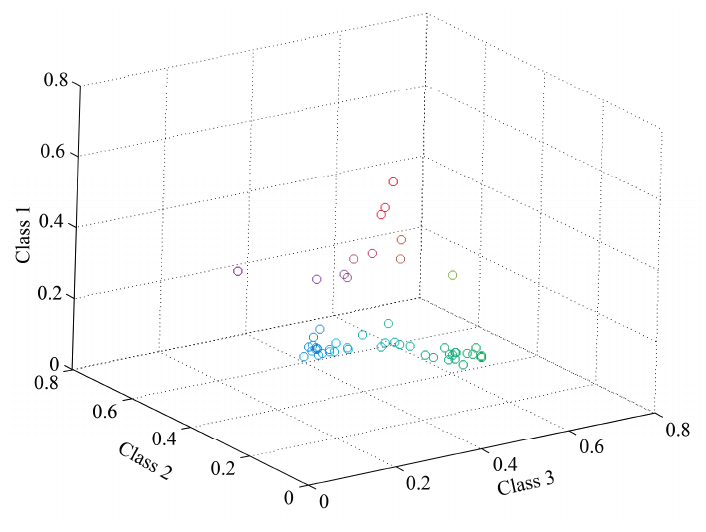
Figure 4. Weighted factors of each type for the validation data.